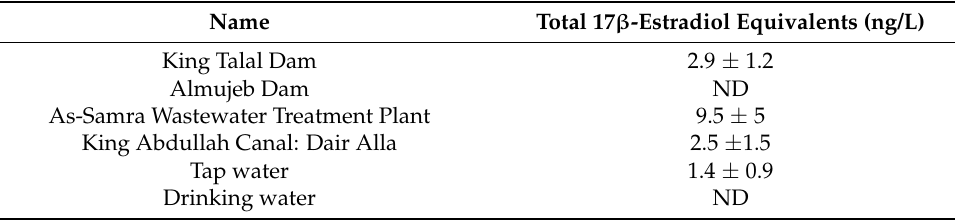
Table 2. The estrogenic activity using the YES